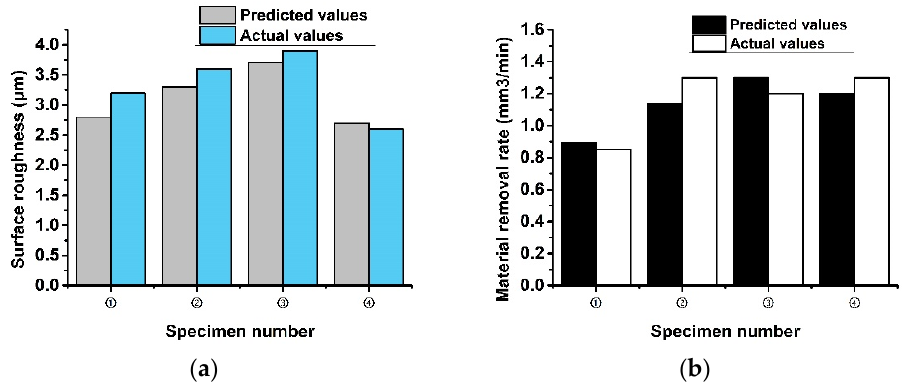
Figure 17. Machining results of predicted versus experimental values: ( a ) surface roughness of different specimens; ( b ) material removal rate results of different specimens.